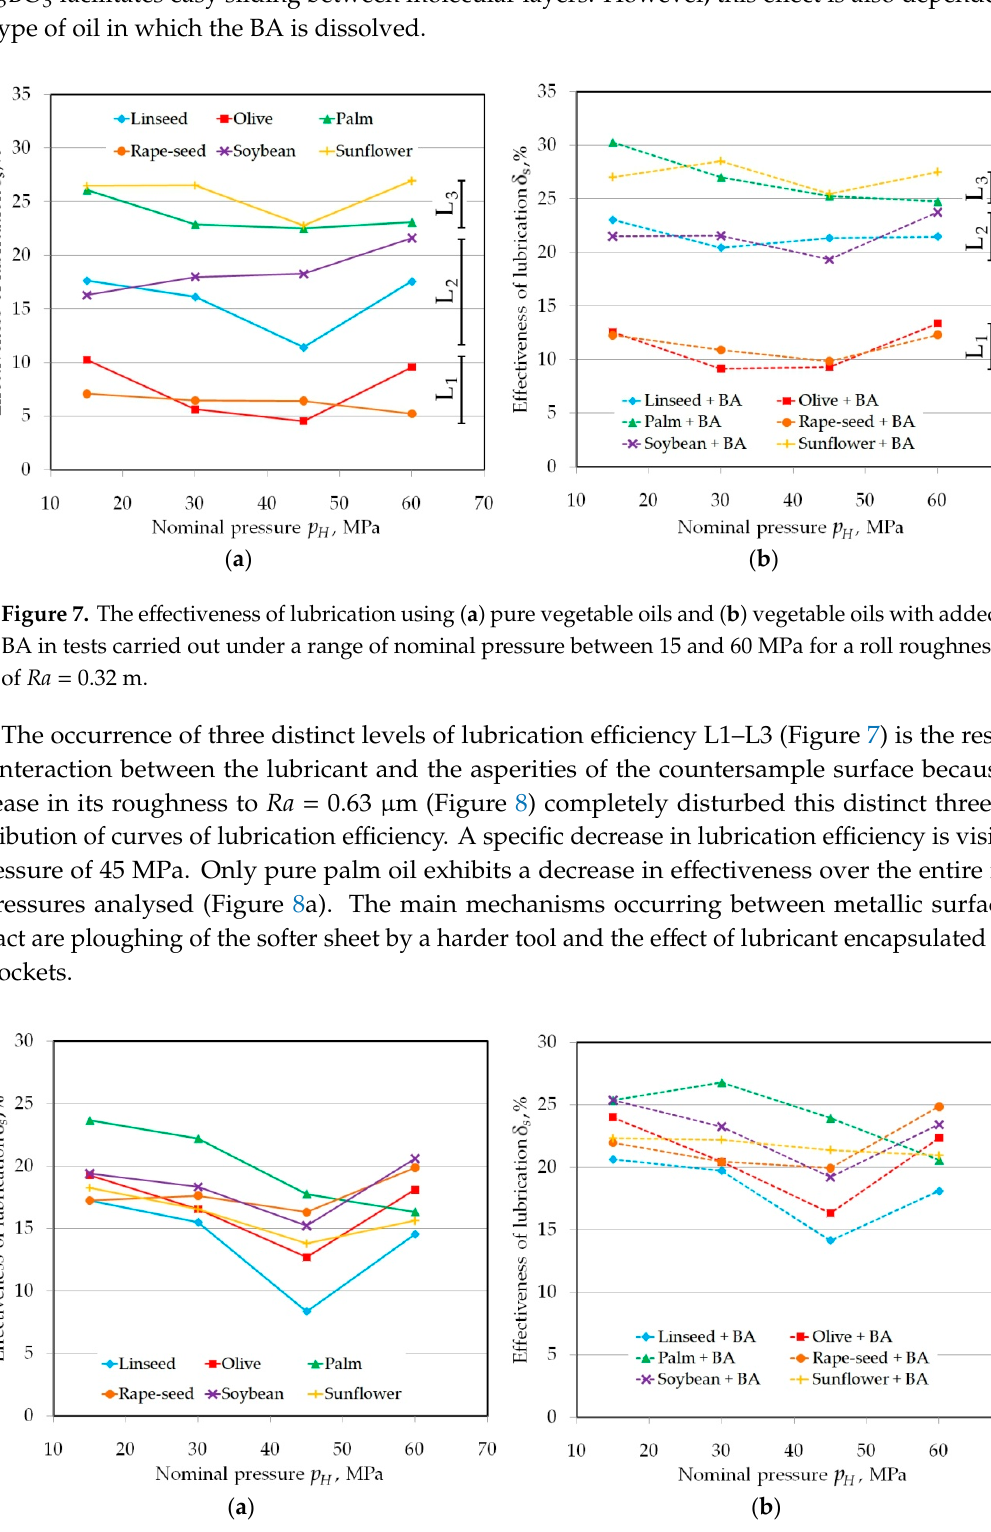
Figure 8. The effectiveness of lubrication using ( a ) pure vegetable oils and ( b ) vegetable oils with added BA in tests carried out under a range of nominal pressure between 15 and 60 MPa for a roll roughness of Ra = 0.63 m.